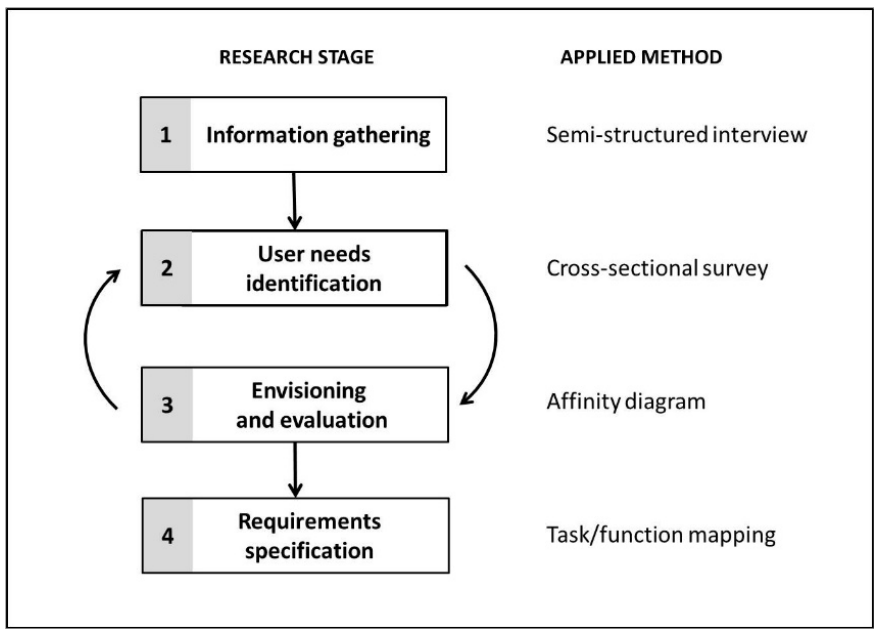
Figure 3. Research architecture to identify user